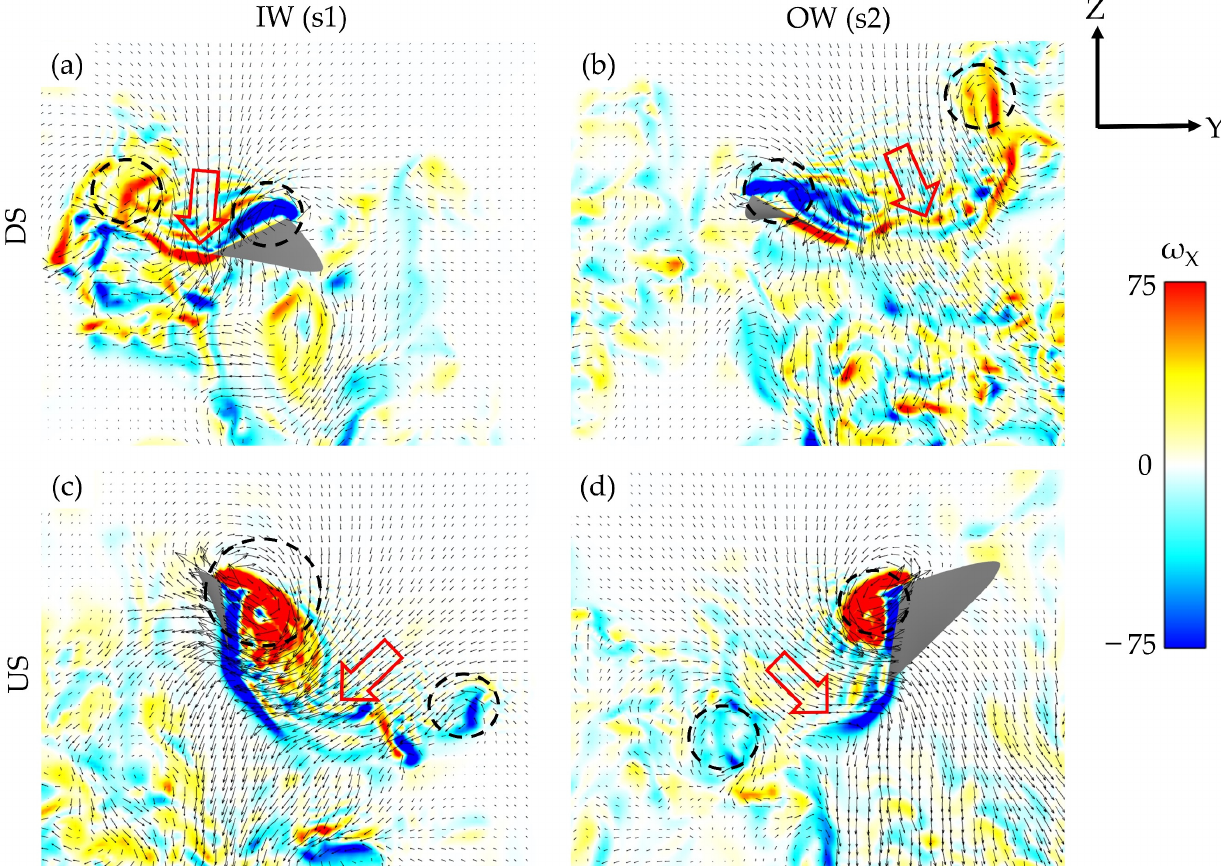
Figure 9. Comparison of wake jets for the IW ( a , c ), OW ( b , d ) during the DS and US,